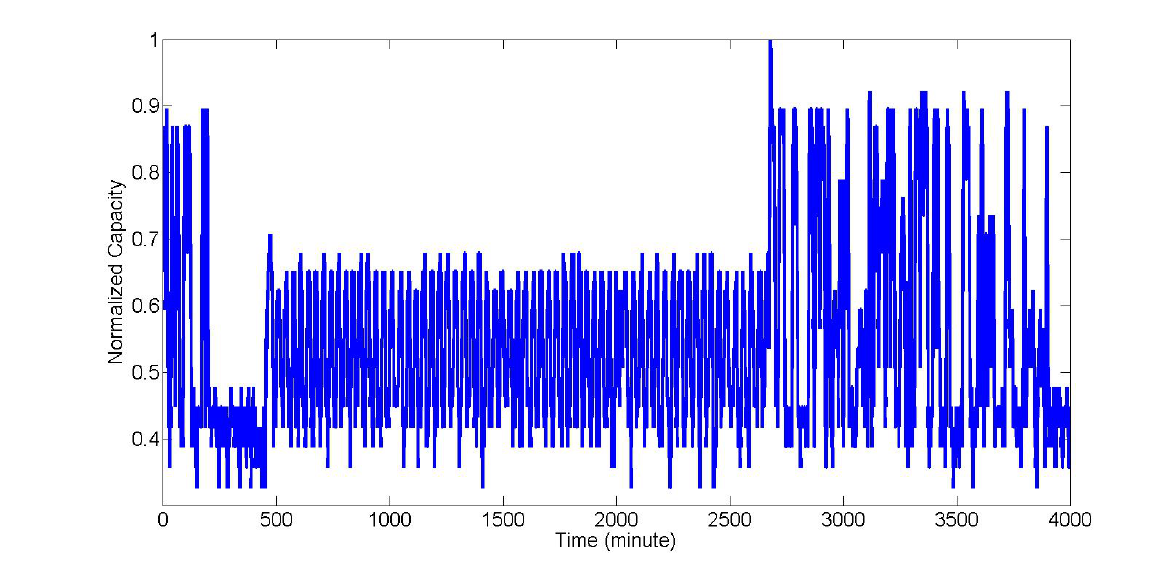
Figure 3. Variation in calculated point-to-point communication Shannon capacity of a WiFi network based on the received signal strength measurements as function of the signal-to-noise ratio with respect to time.